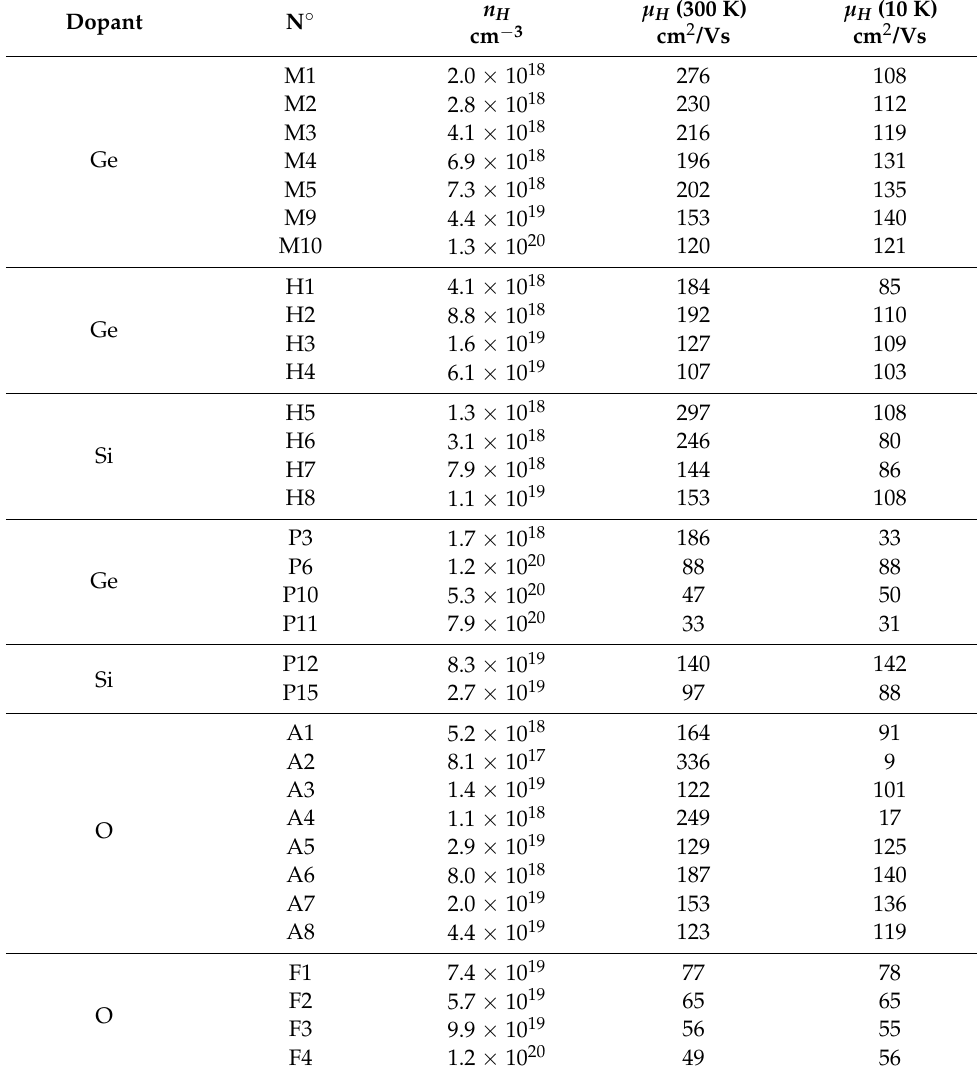
Table 1. Sample characteristics: Hall concentration at 300 K n H (300 K) = 1/( eR H ) and Hall mobility µ H = 1/( e ρ n H ) at 300 K and 10 K